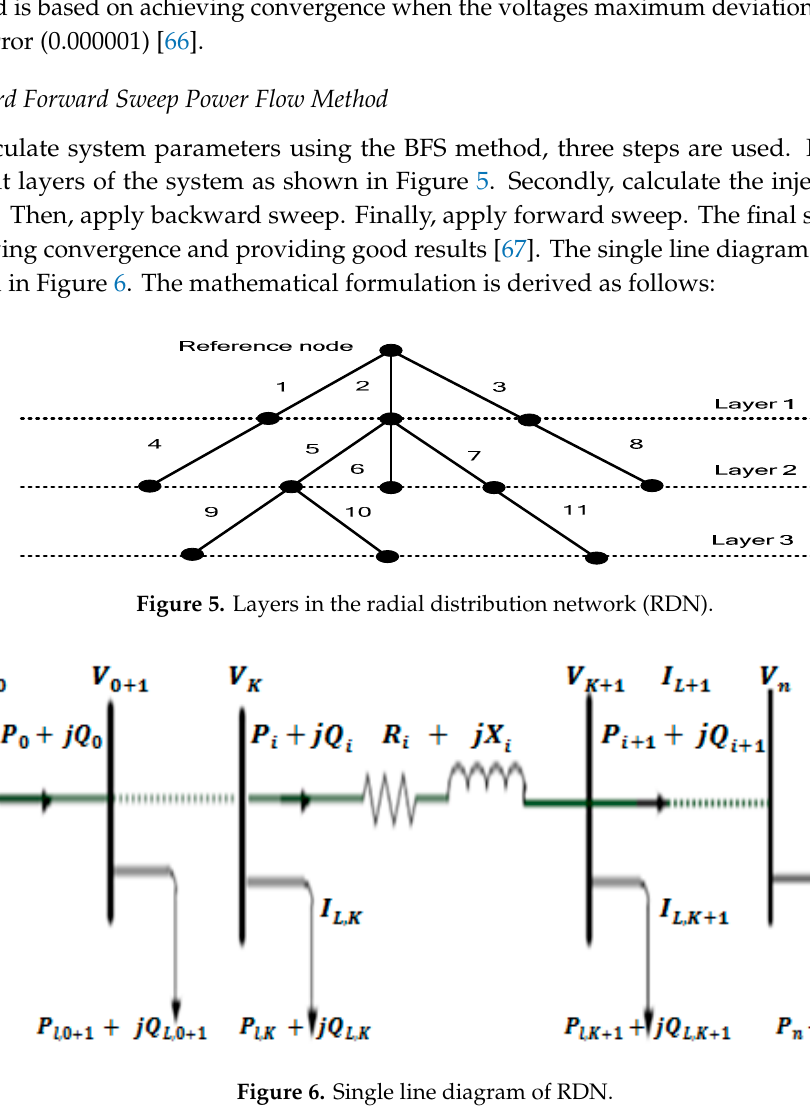
Figure 6. Single line diagram of RDN.